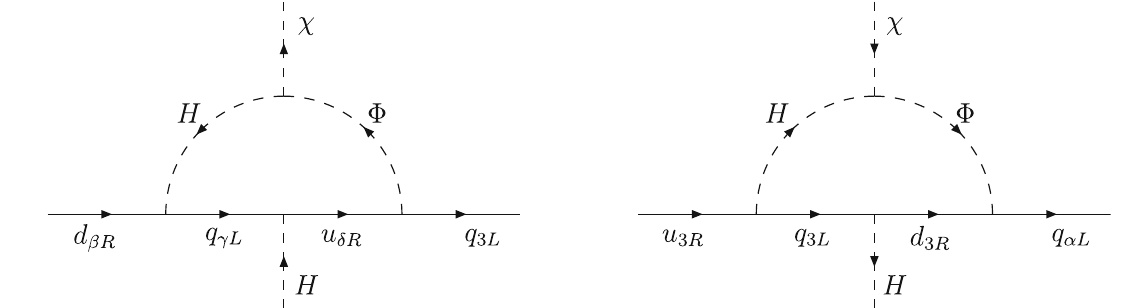
Fig. 1 Yukawa couplings of (cid:5) (cid:7) and ˜ (cid:5) (cid:7) types generated by corresponding Feynman diagrams (left and right) that identify (cid:5) (cid:7) ∼ H χ ∗ and ˜ (cid:5) (cid:7) ∼ ˜ H χ ,